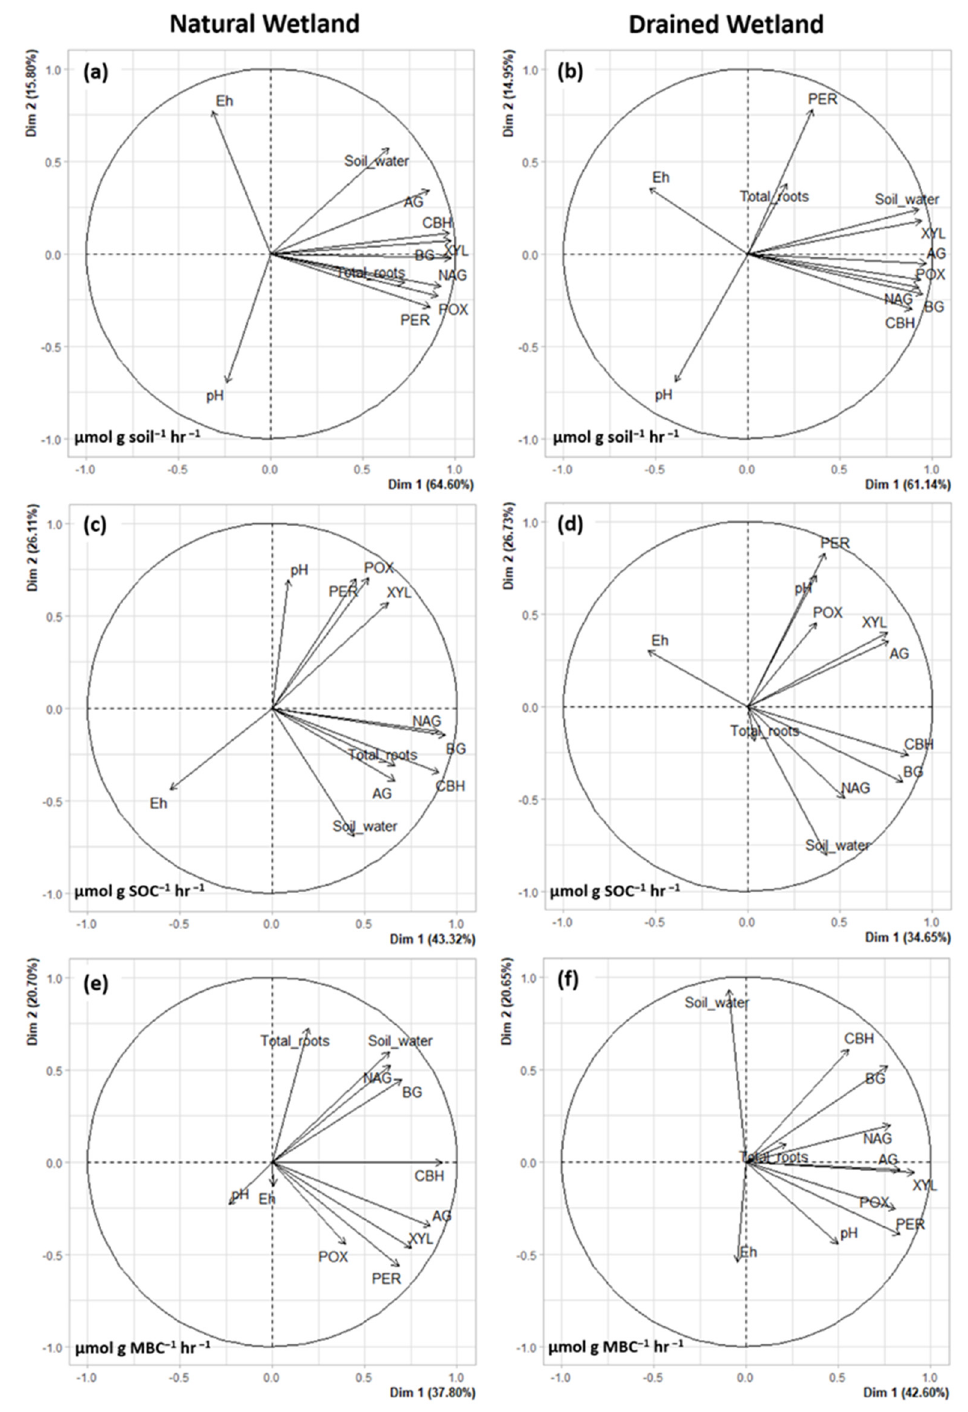
Figure 4. Principal Component Analysis (PCA) showing the relationship between environmental variables (pH, total root biomass, Eh, and soil water content) and extracellular enzyme activity in natural ( a , c , e ) and drained ( b , d , f ) forested wetlands in eastern North Carolina estimated using three different normalization methods ( a , b ): normalized by soil weight; ( c , d ): normalized by soil organic C content; and ( e , f ): normalized by microbial biomass C content. Activity of seven enzymes were measured: α -glucosidase (AG), β -glucosidase (BG), cellobiohydrolase (CBH), xylosidase (XYL), phenol oxidase (POX), peroxidase (PER) and N-acetyl glucosamide (NAG). Data are averaged over soil horizons.